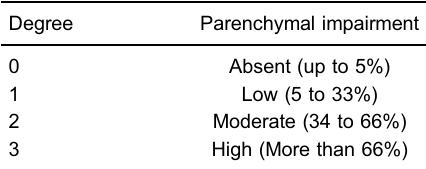
Table 2. Histopathological scoring according to Kleiner et al. (15), depending on the extension and involvement of the hepatic